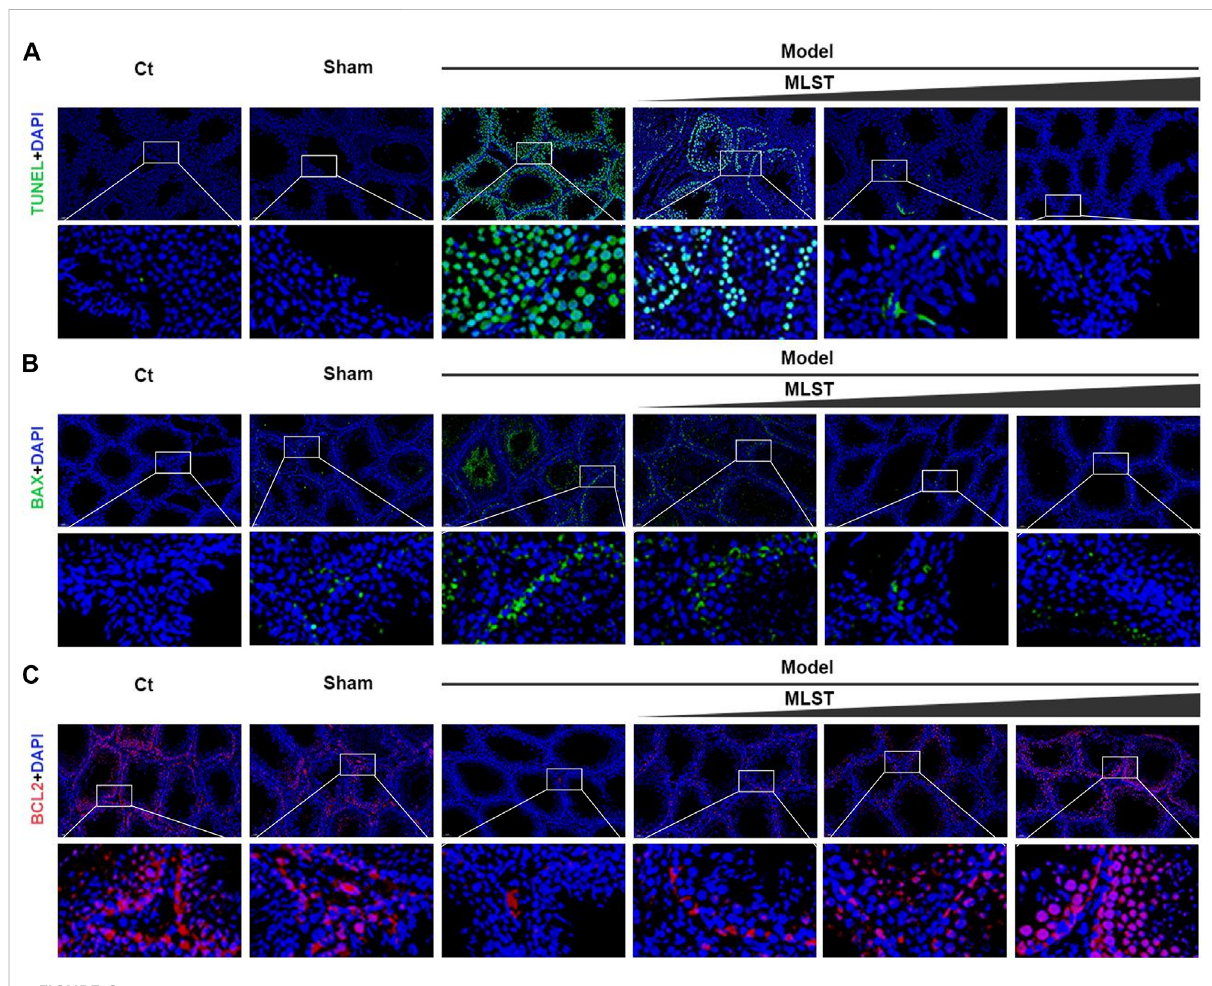
FIGURE 6 Effect of MLST on VC-induced apoptosis of rat testicular cells. (A) Green indicates TUNEL positive; Blue indicates cell nucleus stained by DAPI. (B) Green indicates DAPI staining of BAX; Blue indicates cell nucleus stained by DAPI. (C) Red indicates DAPI staining of BCL2; Blue indicates cell nucleus stained by